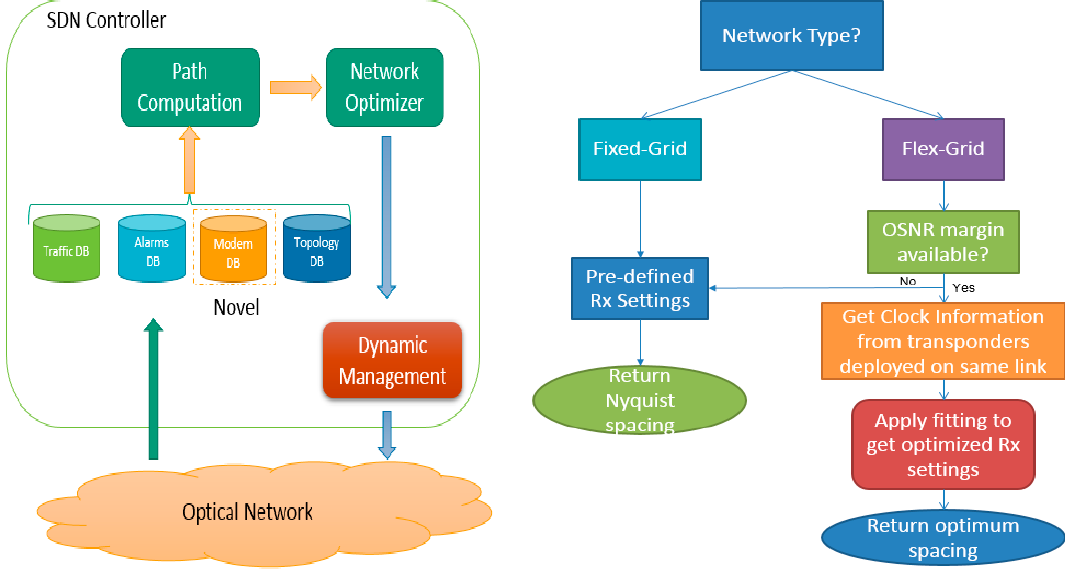
Figure 8. Model of SDN controller (left) and high-level flow of proposed method (right).